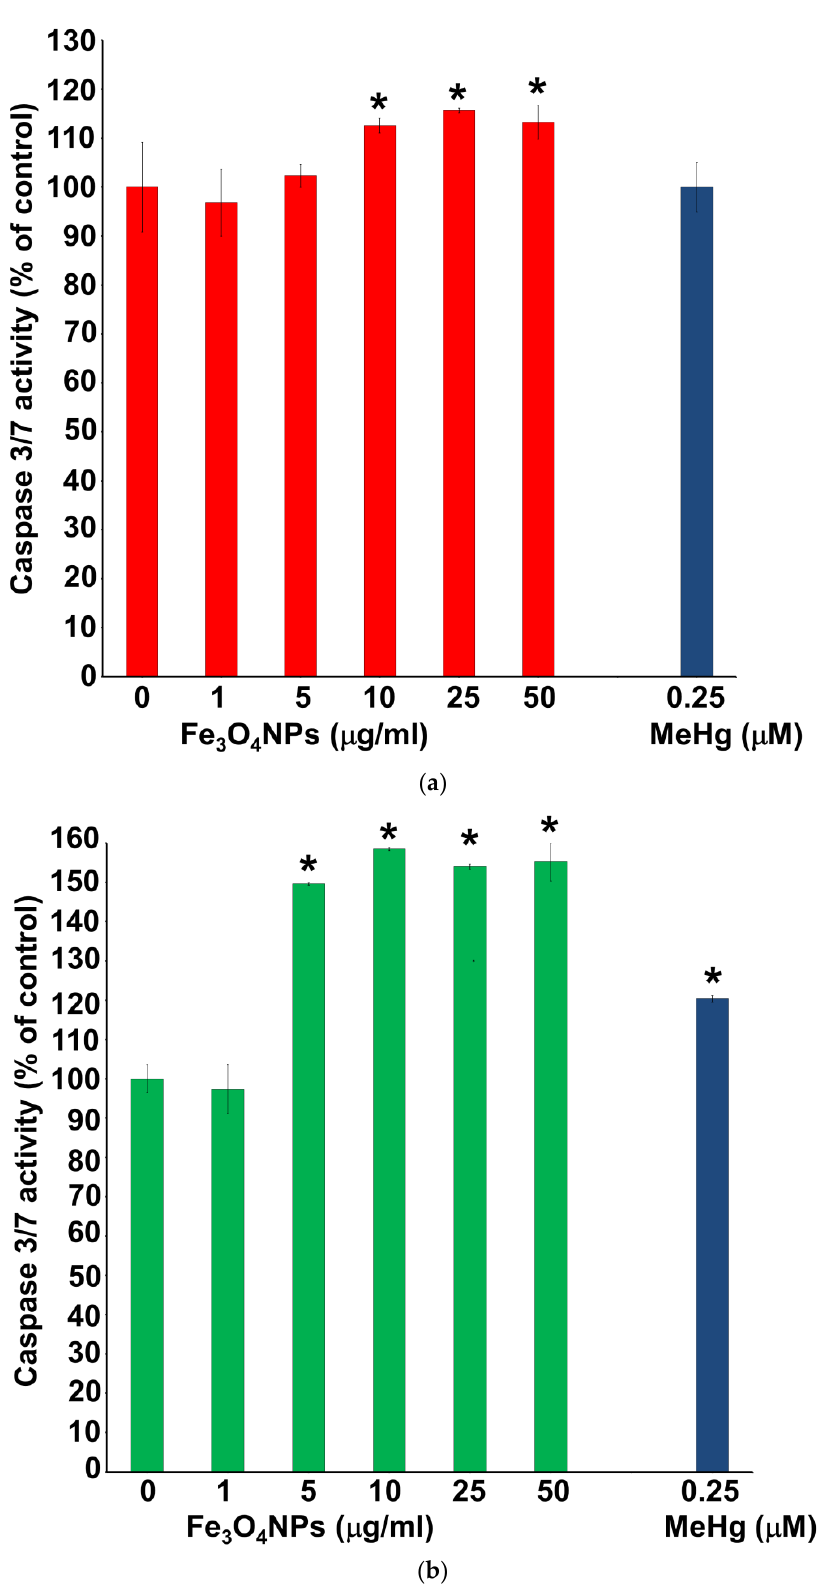
Figure 9. Caspase 3 / 7 activity evaluation in hNLCs treated with Fe 3 O 4 NPs. An increase of caspase 3 / 7 activity levels was observed in hNLCs starting from 10 µ g / mL ( + 1.1-fold) at day 3 ( a ) and 5 µ g / mL ( + 1.5-fold) at day 8 ( b ) of transdi ff erentiation. MeHg was used as positive control. Data represent the mean ± S.D. * p < 0.05. Statistical analysis by two-way ANOVA followed by Dunnett’s test.